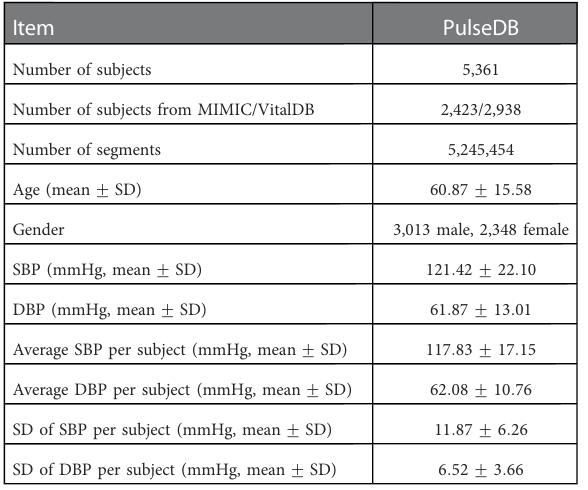
TABLE 3 Summary of statistical information of the proposed PulseDB dataset.